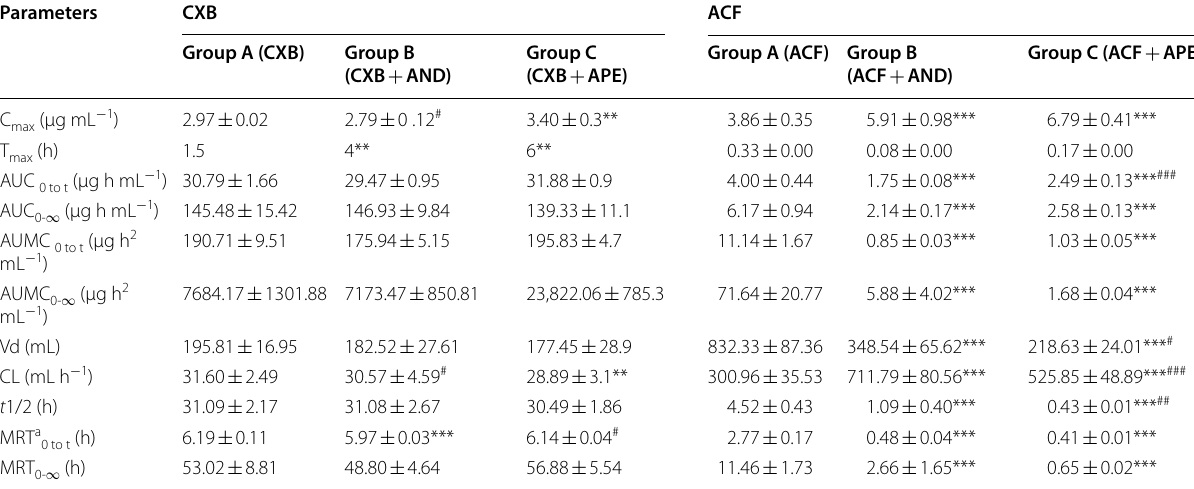
Values are expressed as one-way ANOVA followed by Bonferronis multi comparison test n